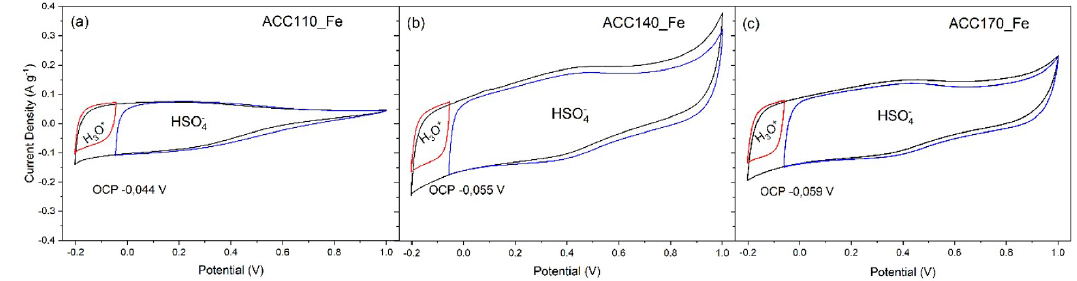
SO 2 mol L -1 . 2 4